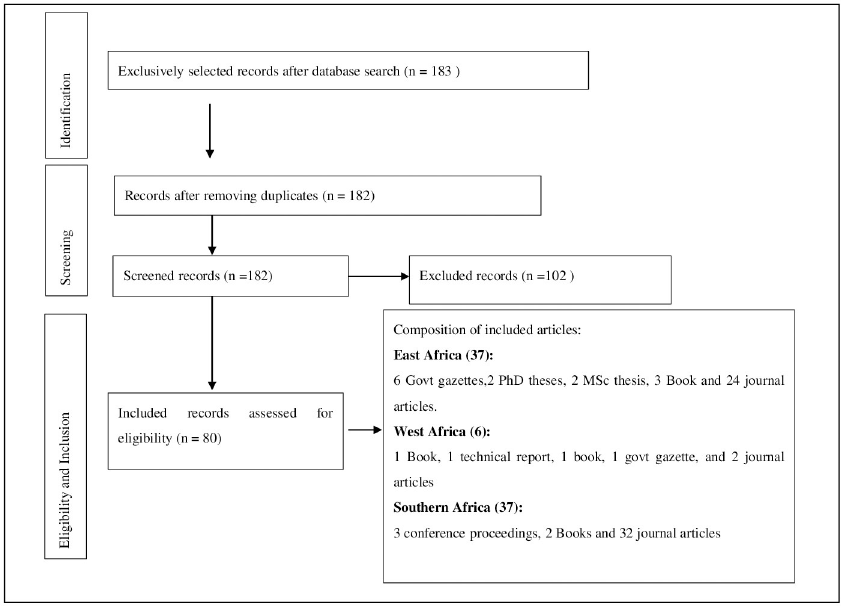
Fig 1. Systematic review flowchart based on PRISMA flowchart